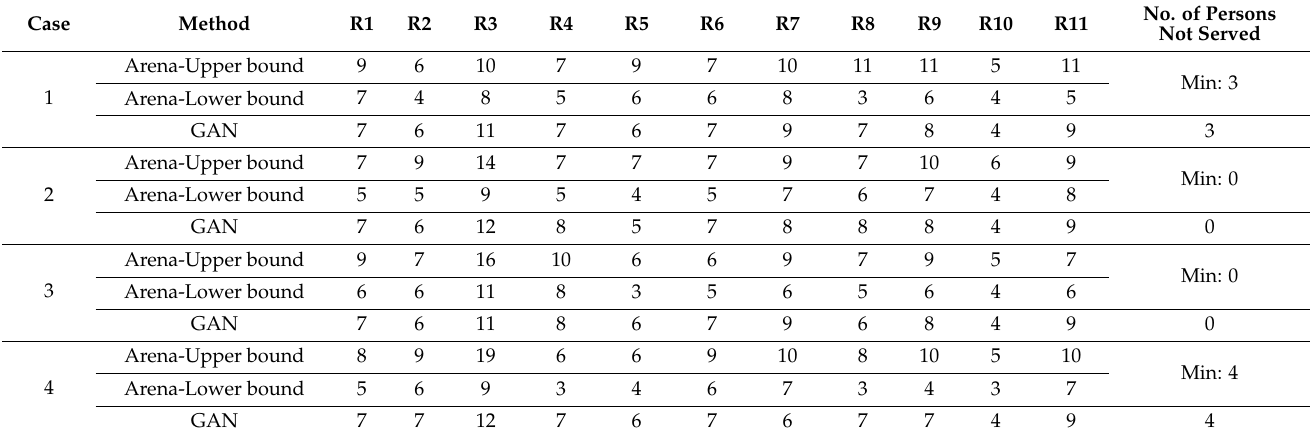
Table 9. Results of Arena and GAN’s Station-Car were used in first four Req-Reg cases.